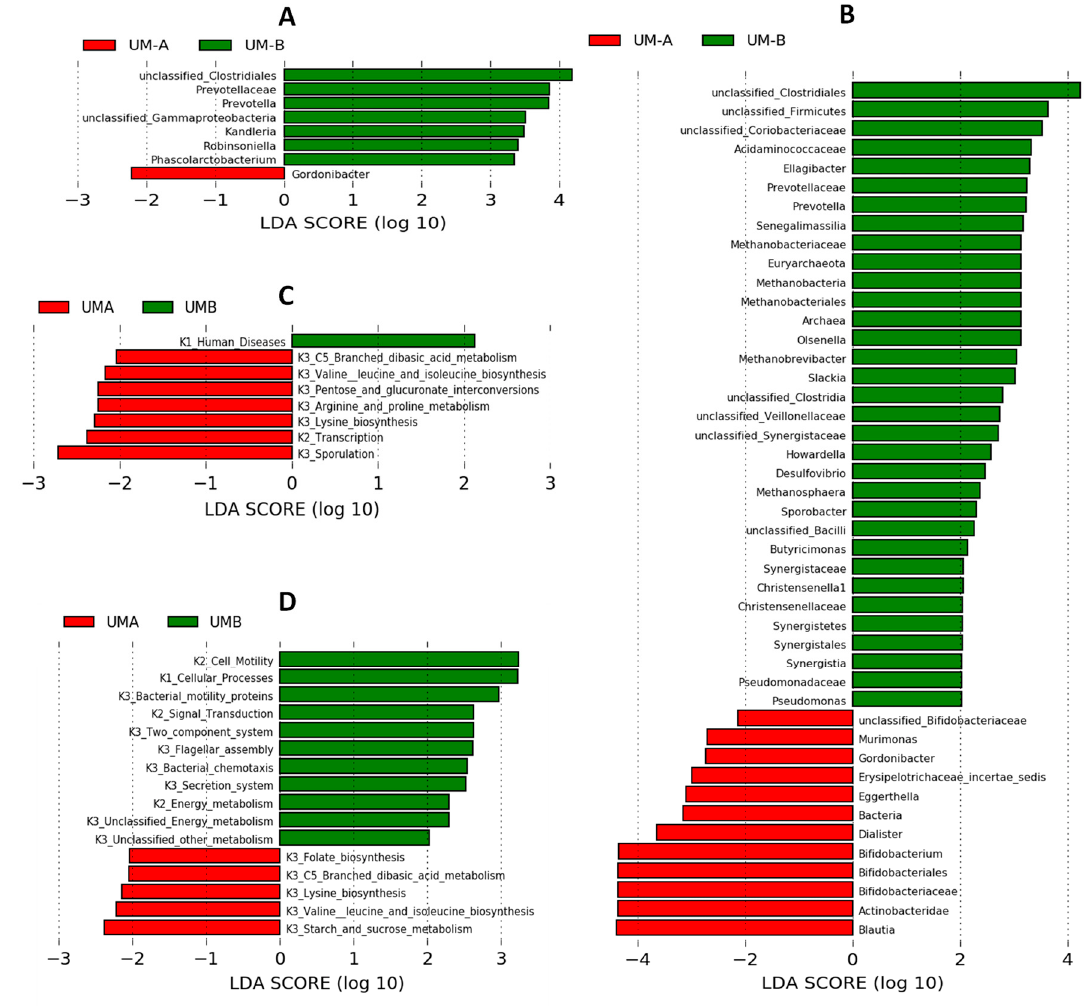
Figure 4. Linear discriminant analysis (LDA) e ff ect size (LEfSe) analysis of gut microbiota that shows di ff erent abundances between urolithin metabotypes (Ums) in the maternal fecal microbiome ( A , B ), and the inferred functional capacity of the fecal microbiome ( C , D ) at T1 ( A , C ) and T4 ( B , D ). Positive LDA scores (green bars) are enriched in UM-B while negative LDA scores (red bars) are enriched in UM-A. The microbial taxa and functions shown in the figure have a LDA score higher than 2.